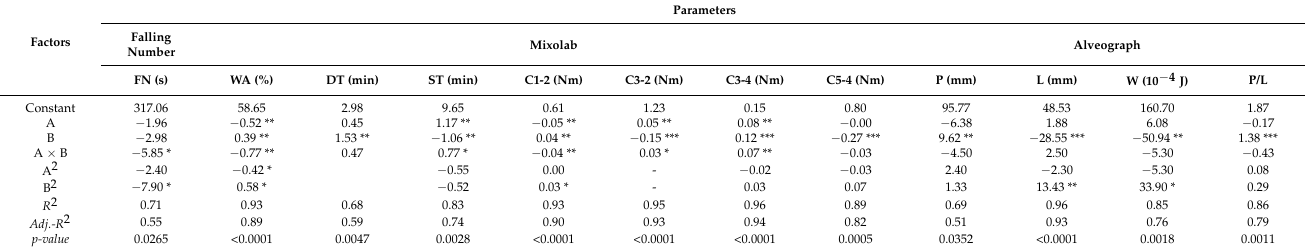
Table 3. The coefficients in the predictive models for the FN index, Mixolab, and alveograph